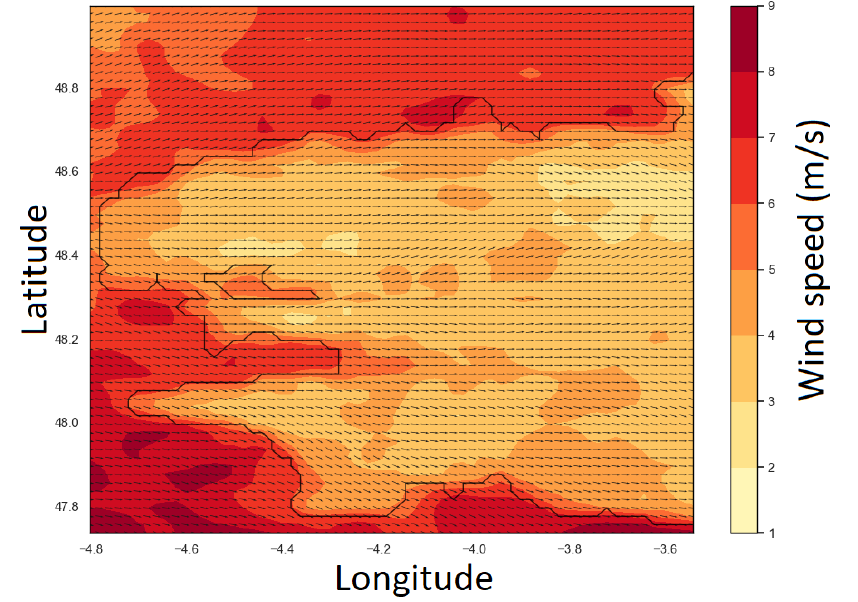
Figure 2. An example of wind map restricted to the study area acquired on the 6 My 2017 at 20:25:00. Wind speed is represented by the color scale and velocity direction is indicated with